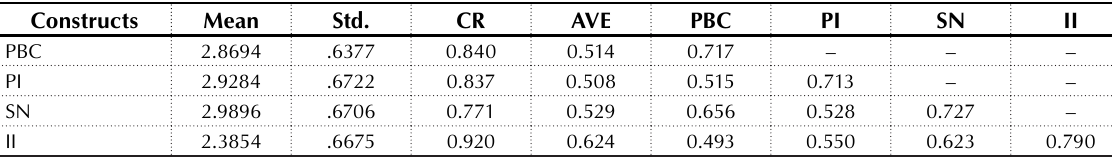
Table 2. Constructs reliability and validity Constructs